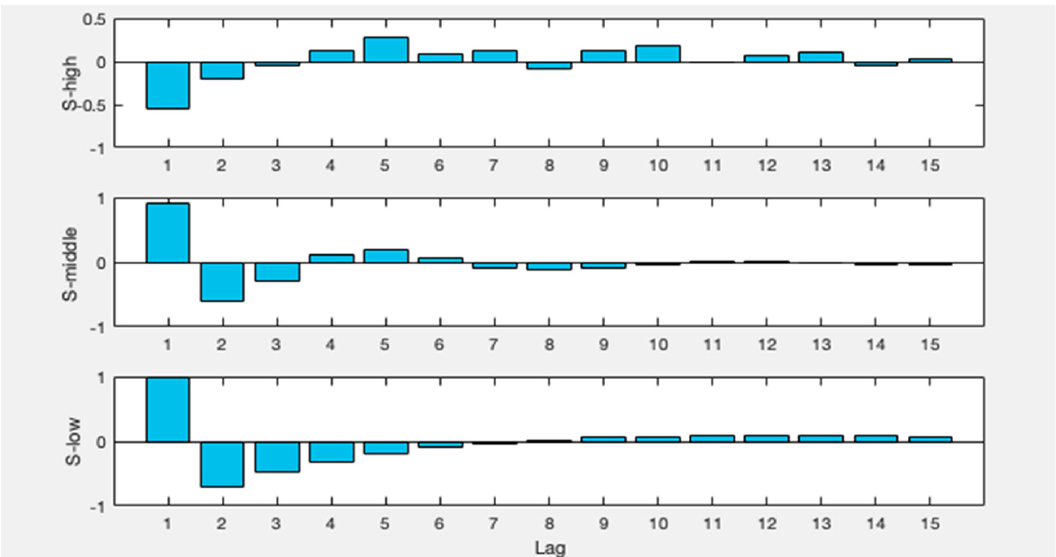
Figure 12. The PACF results of Signal reconstruction by EEMD of “Yangdong Line.” Table 3. Input factors selected by the PACF method of “Yangdong Line.”